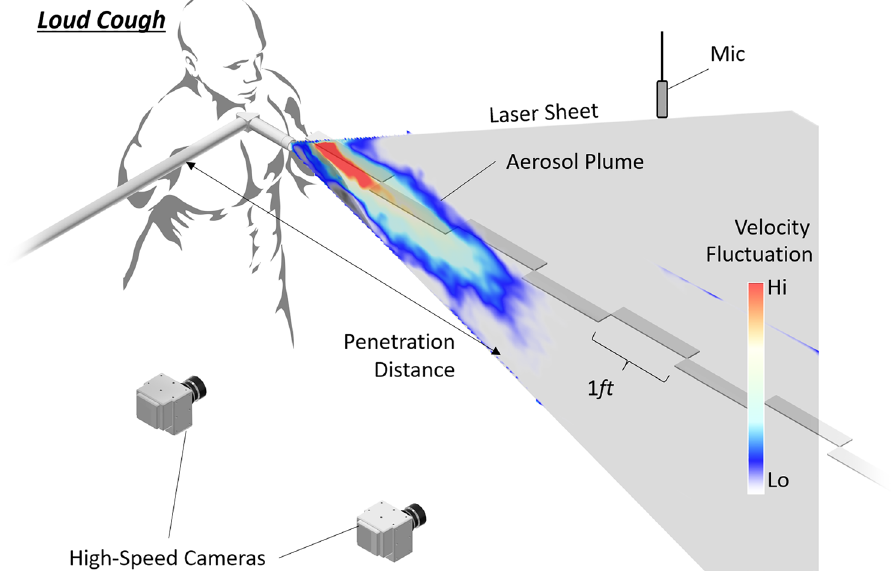
Figure 7. Illustration of the experimental setup superimposed with the velocity of the cough